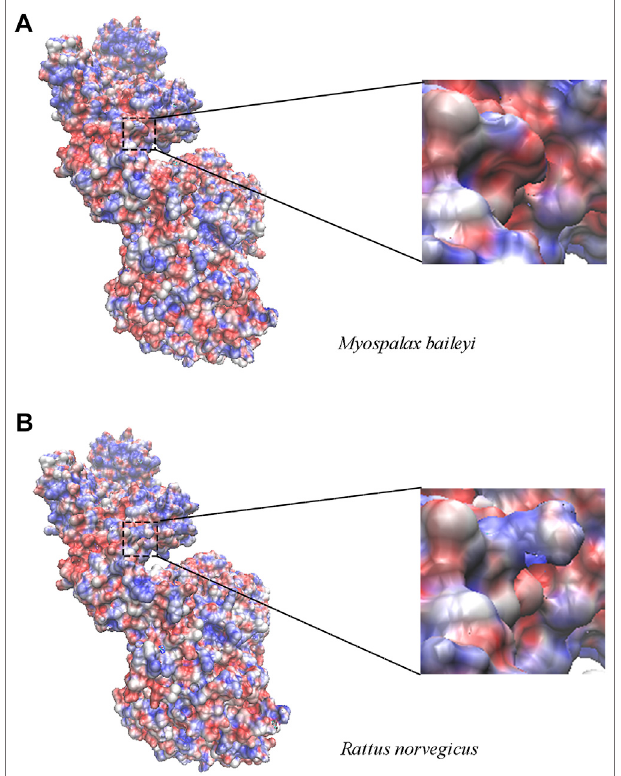
FIGURE 3 | The electrostatic potential map of Apaf1 in plateau zokor ( Myospalax baileyi ) (A) and Sprague – Dawley rat ( Rattus norvegicus ) (B) . The rangeofsurfaceelectrostaticpotentialwasshownfrom-7kT/eto7kT/einred and blue, respectively. At the right panel, the surface electrostatic potential around the substitution sites was enlarged at residue